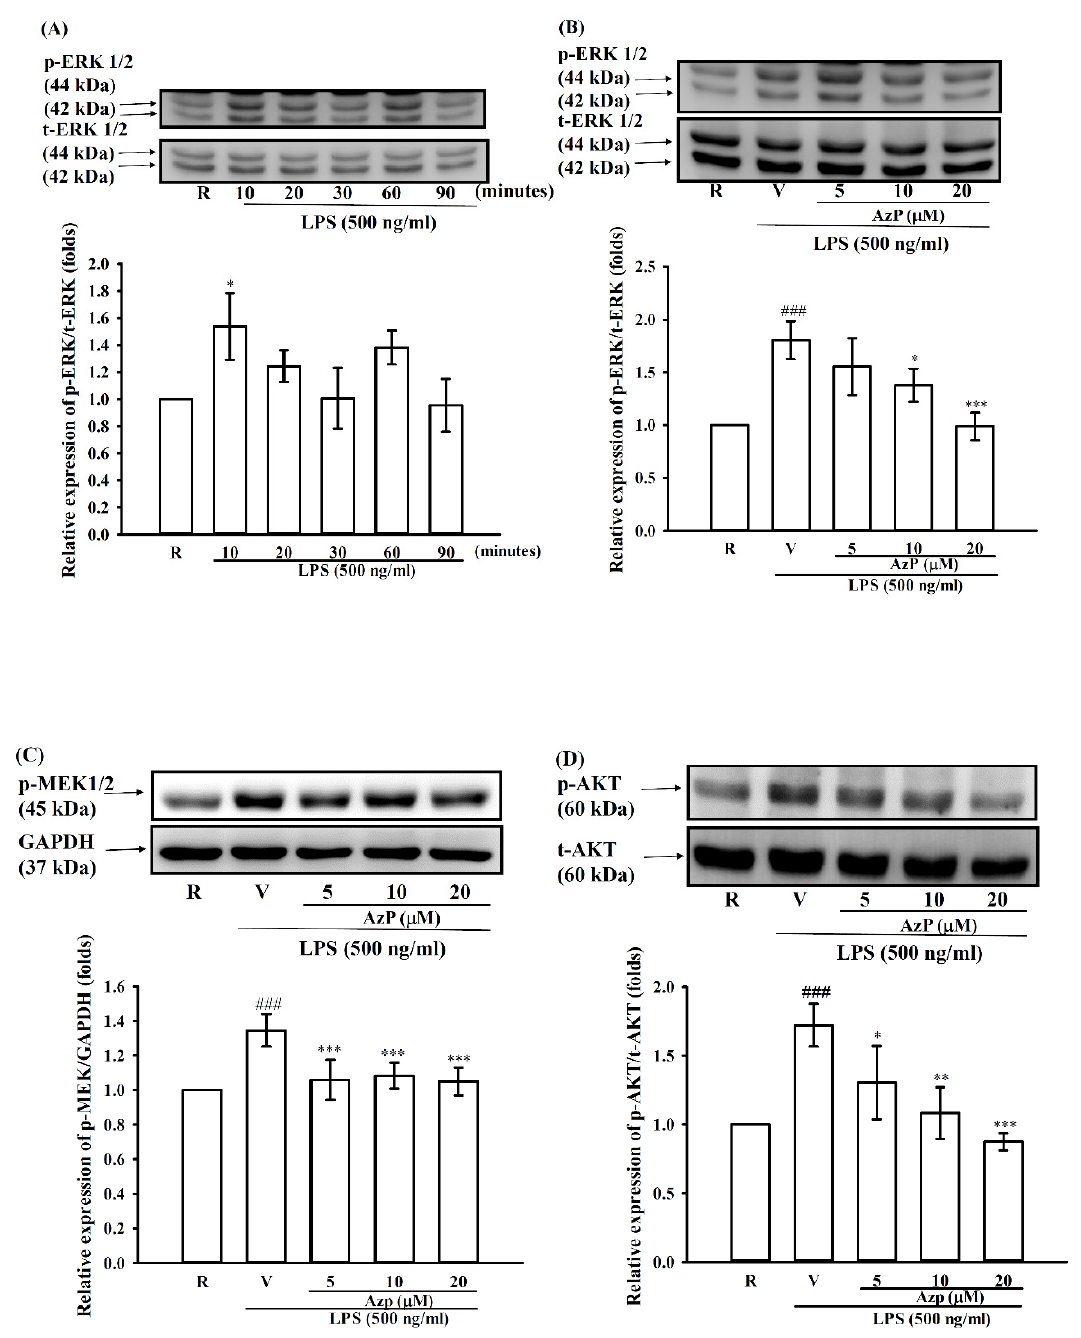
Figure 6. Western blotting of IEC-6 cells treated with LPS and/or AzP. ( A ) IEC-6 cells (1 × 10 6 cells/mL) were dispensed on 6 cm dishes and ( A ) treated with LPS (500 ng/mL) for 10, 20, 30, 60, and 90 min. Data expressed as means ± SD from 3 independent experiments. * p < 0.05 as compared with the resting. ( B ) Treatment with LPS (500 ng/mL) for 10 min as indicated. Cells were treated with the indicated concentrations of AzP (5, 10, and 20 µ M) or vehicle for 30 min before treatment with LPS. Cell lysates were collected for Western blot targeting p-ERK phosphorylation (Thr202/Tyr204, B ), MEK phosphorylation (Ser271/221, C ), and Akt phosphorylation (Ser473, D ). Data expressed as means ± SD from 3 independent experiments. ### p < 0.001 as compared with the resting, * p < 0.05, ** p < 0.01 and *** p < 0.001 as compared with the vehicle.